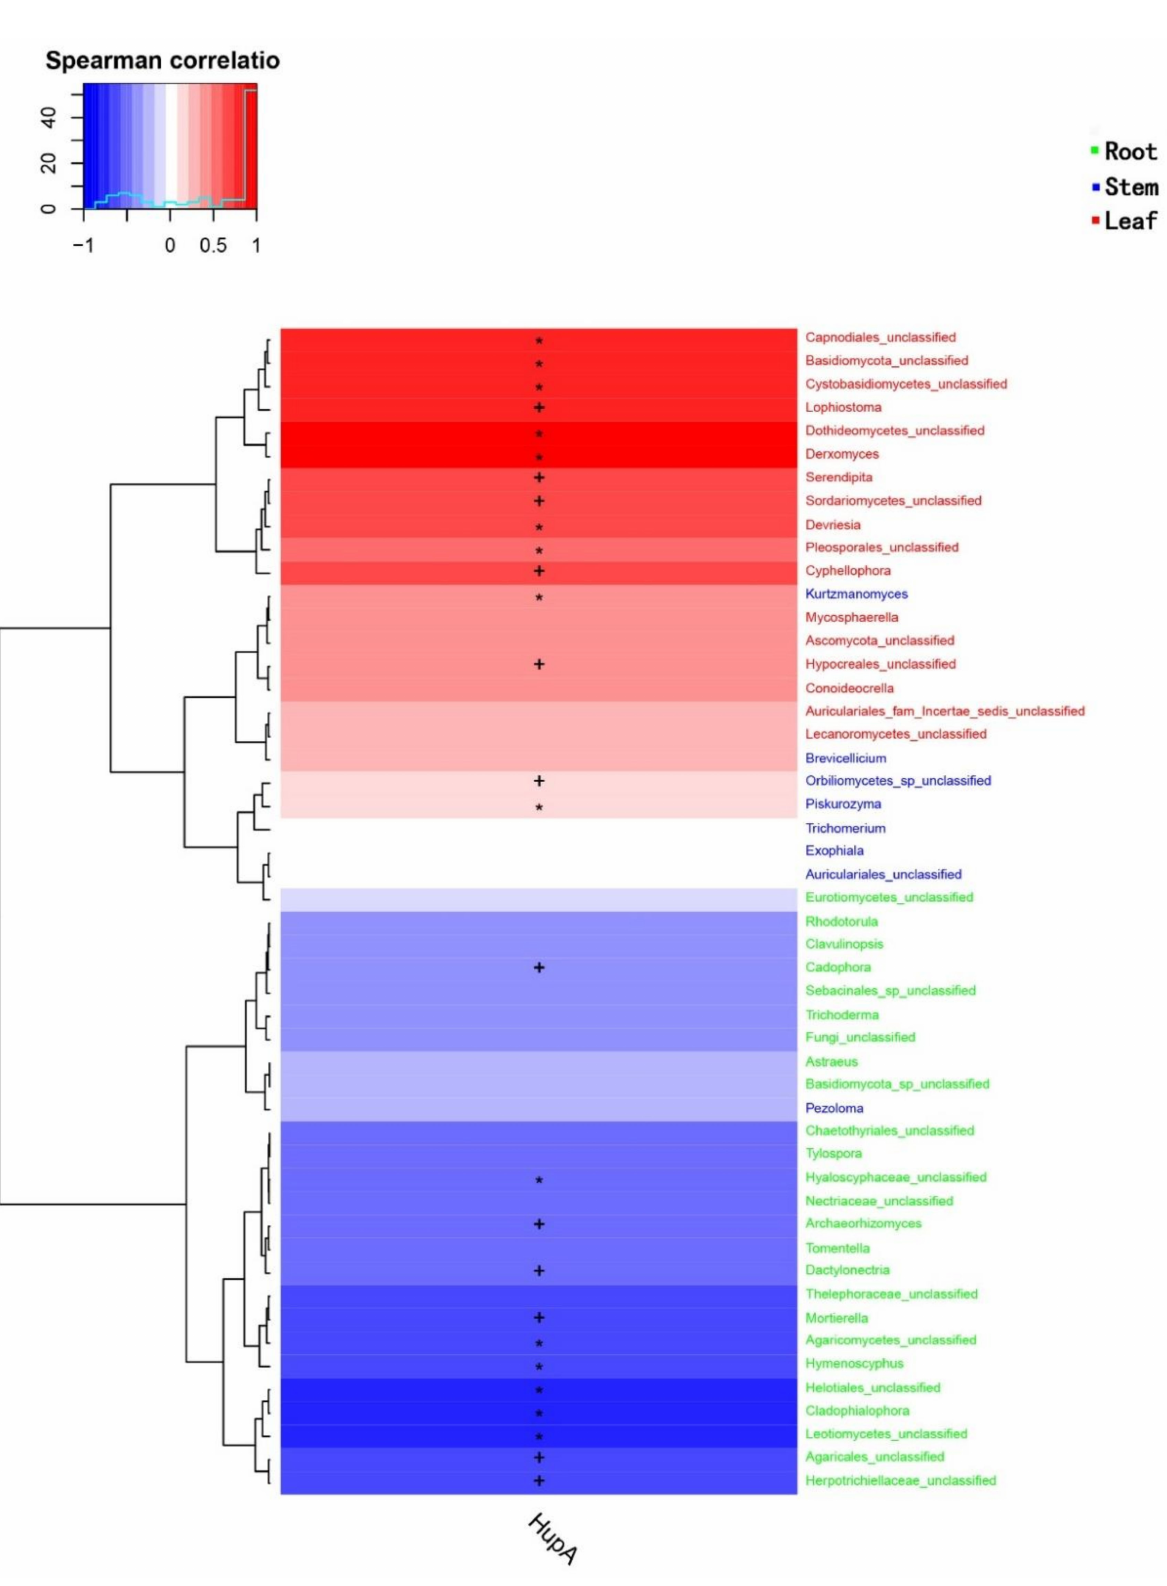
Figure 6. The correlation of HupA content with endophytic fungi within H. serrata. Whereas, + indicate p < 0.05 and * indicate p <